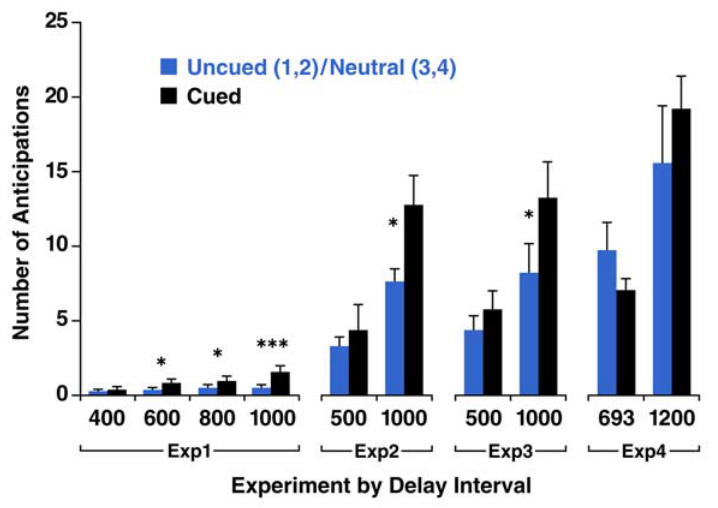
FIGURE 2. Anticipatory responses, Experiment 1 and all others. Anticipations before the target onset for cued, no cue, or neutral trials at each delay interval for all four experiments. Generally, more anticipations were made at the longer delay intervals on cued trials. Asterisks (*) indicate the degree of significance (i.e., one asterisk indicates p < 0.05, two p < 0.01, three p < 0.001, four p <0.0001). These same markings are used in all figures. Exp1, Experiment 1; Exp2, Experiment 2; Exp3, Experiment 3; Exp4, Experiment